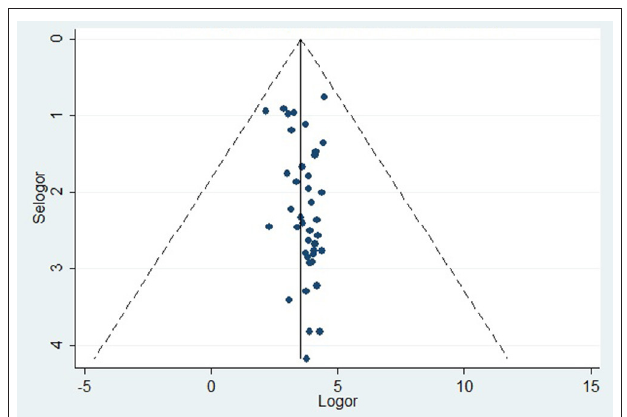
FIGURE 3 | Funnel